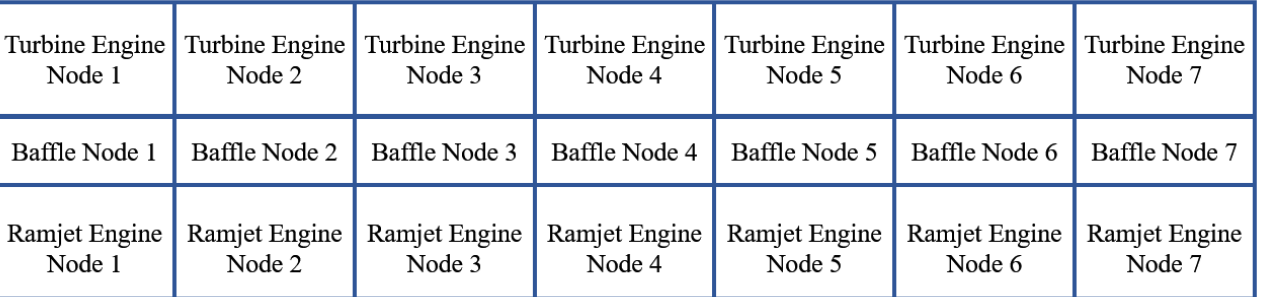
Figure 4. Node division.